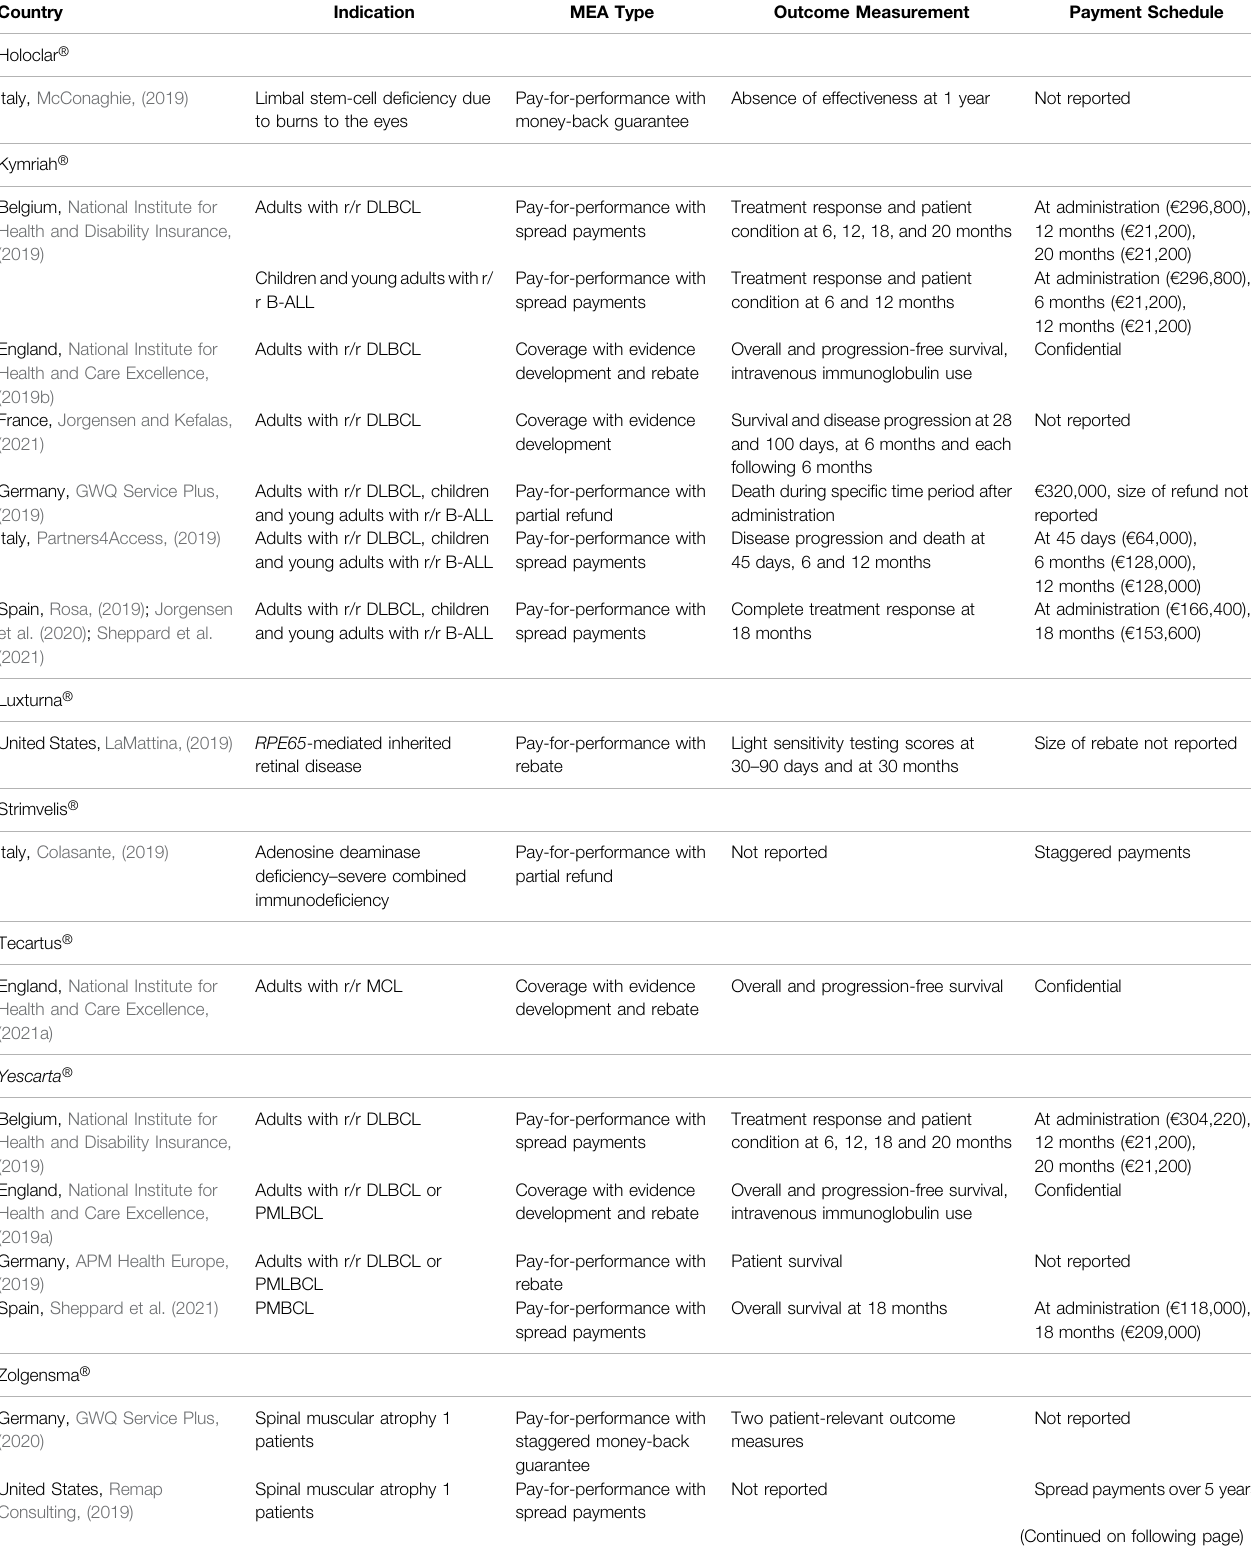
TABLE 3 | Examples of outcome-based managed entry agreements for advanced